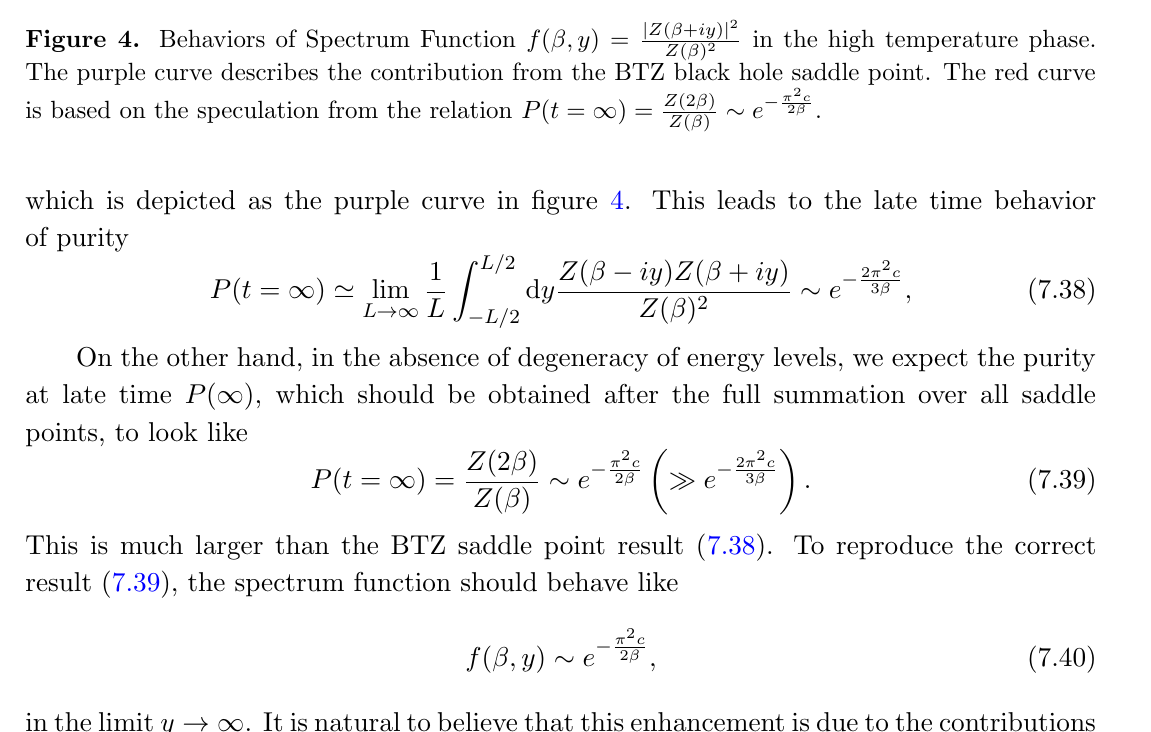
Figure 4. Behaviors of Spectrum Function f ( (cid:12); y ) = j Z ( (cid:12) + iy ) j 2